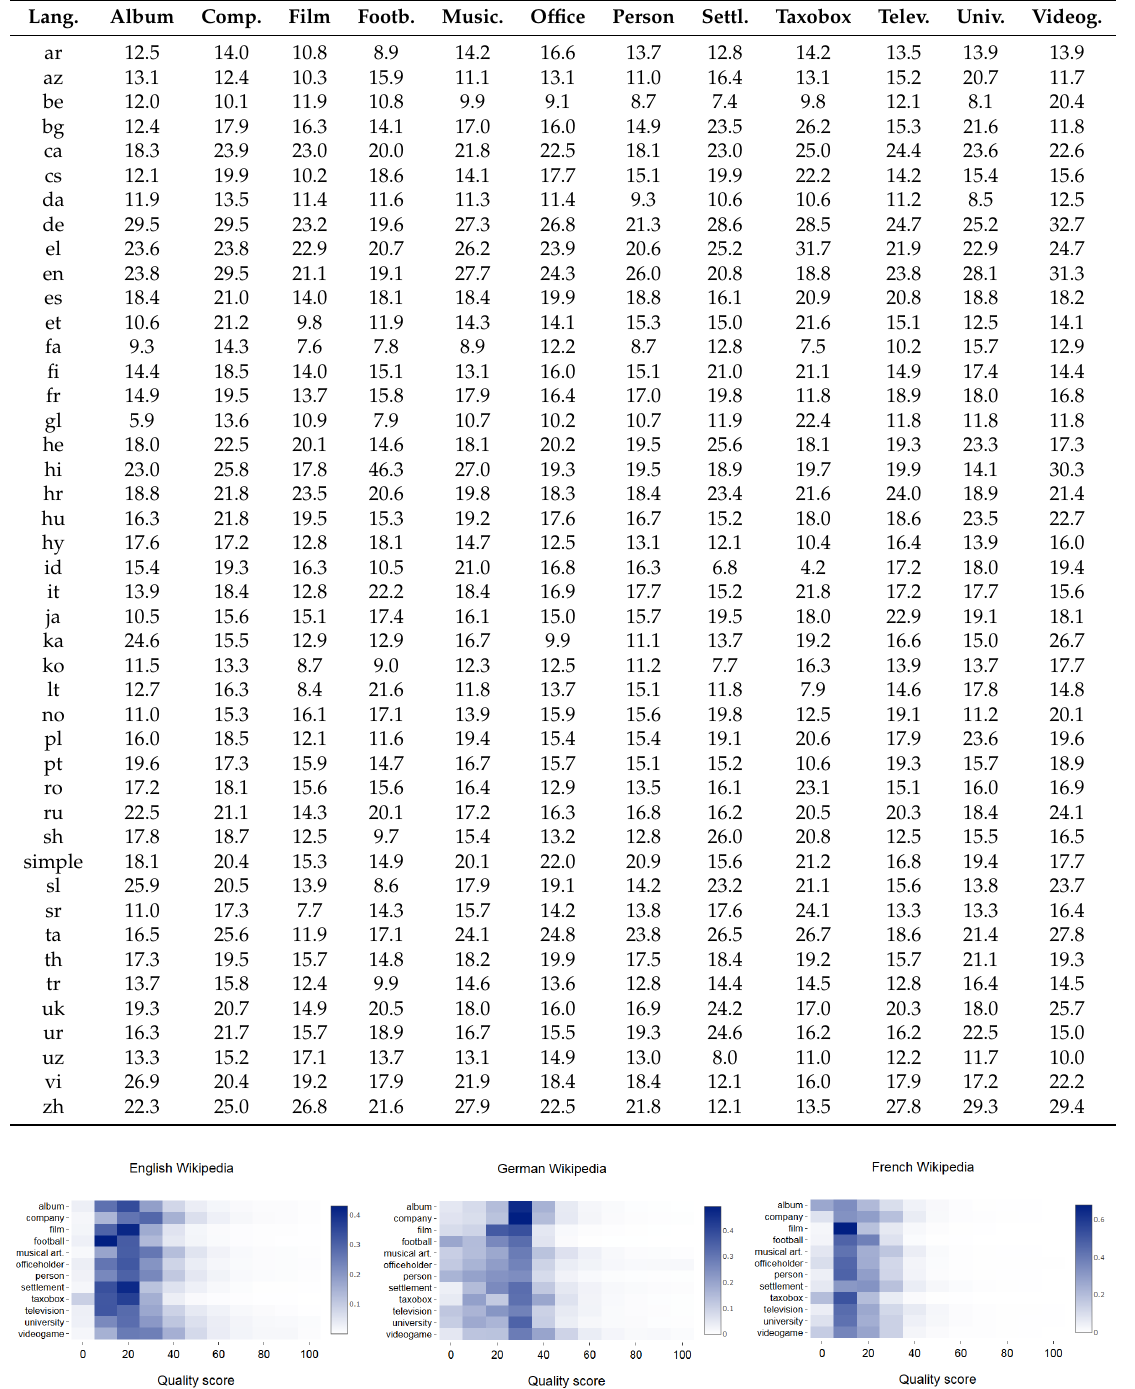
Table 7. Average quality scores of articles for each topic in 44 Wikipedia language editions. Source: own calculations. Lang.